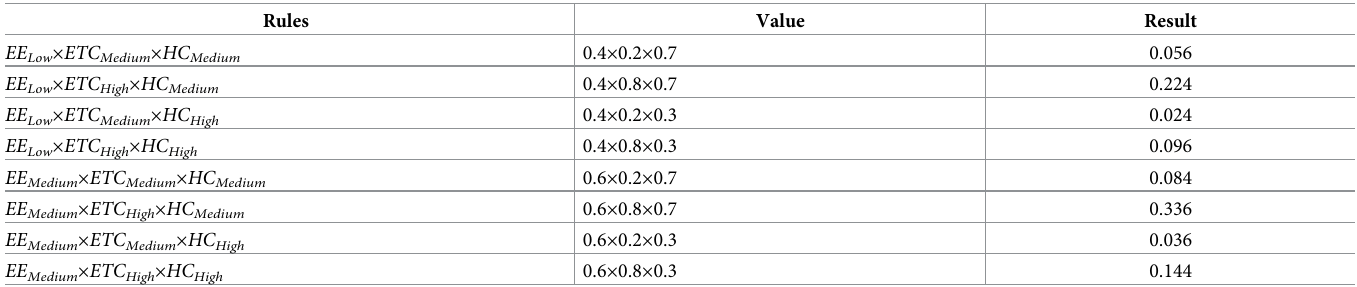
Table 2. Showing each rule and its numerical